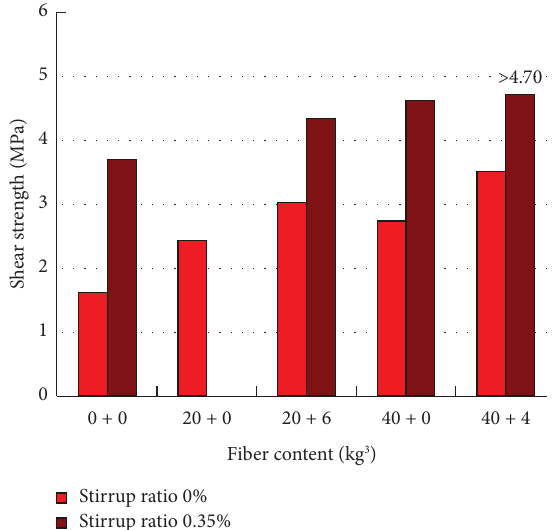
Figure 10: Shear strength with diferent fber dosages.